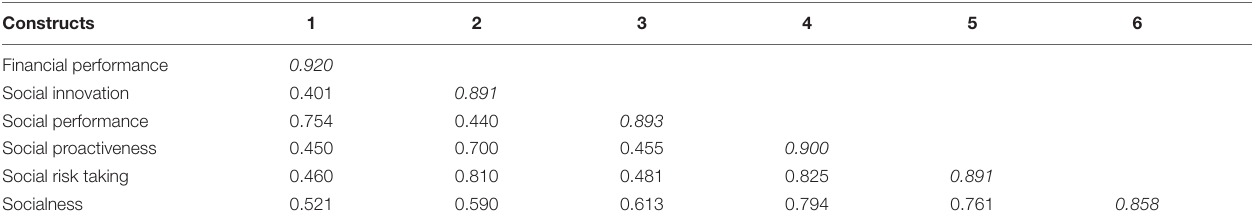
TABLE 5 | Discriminant